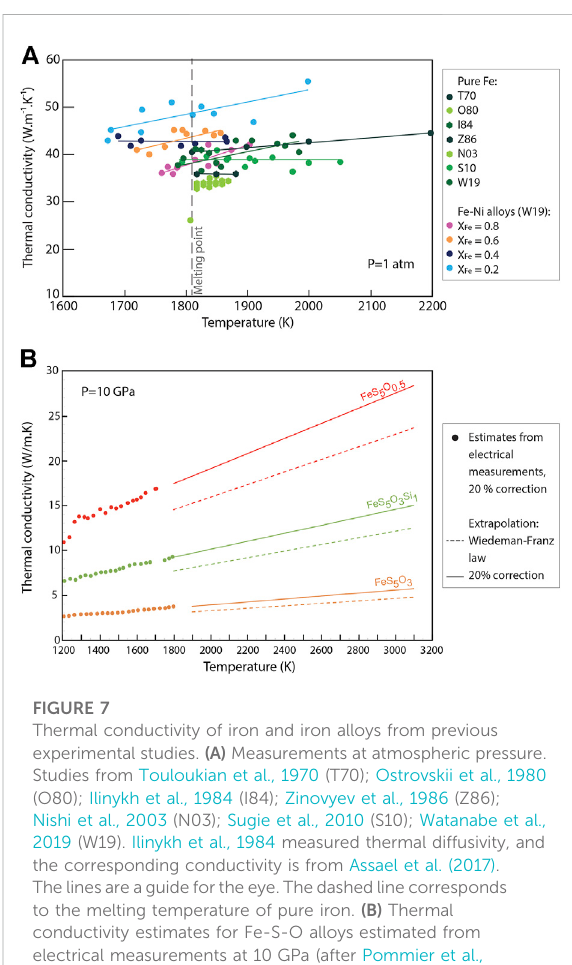
FIGURE 7 Thermal conductivity of iron and iron alloys from previous experimental studies. (A) Measurements at atmospheric pressure. Studies from Touloukian et al., 1970 (T70); Ostrovskii et al., 1980 (O80); Ilinykh et al., 1984 (I84); Zinovyev et al., 1986 (Z86); Nishi et al., 2003 (N03); Sugie et al., 2010 (S10); Watanabe et al., 2019 (W19). Ilinykh et al., 1984 measured thermal diffusivity, and the corresponding conductivity is from Assael et al. (2017). Thelinesareaguidefortheeye.Thedashedlinecorresponds to the melting temperature of pure iron. (B) Thermal conductivity estimates for Fe-S-O alloys estimated from electrical measurements at 10 GPa (after Pommier et al., 2020a).Estimatesaccount fora20%correctiononthevalues obtained using the Wiedemann-Franz